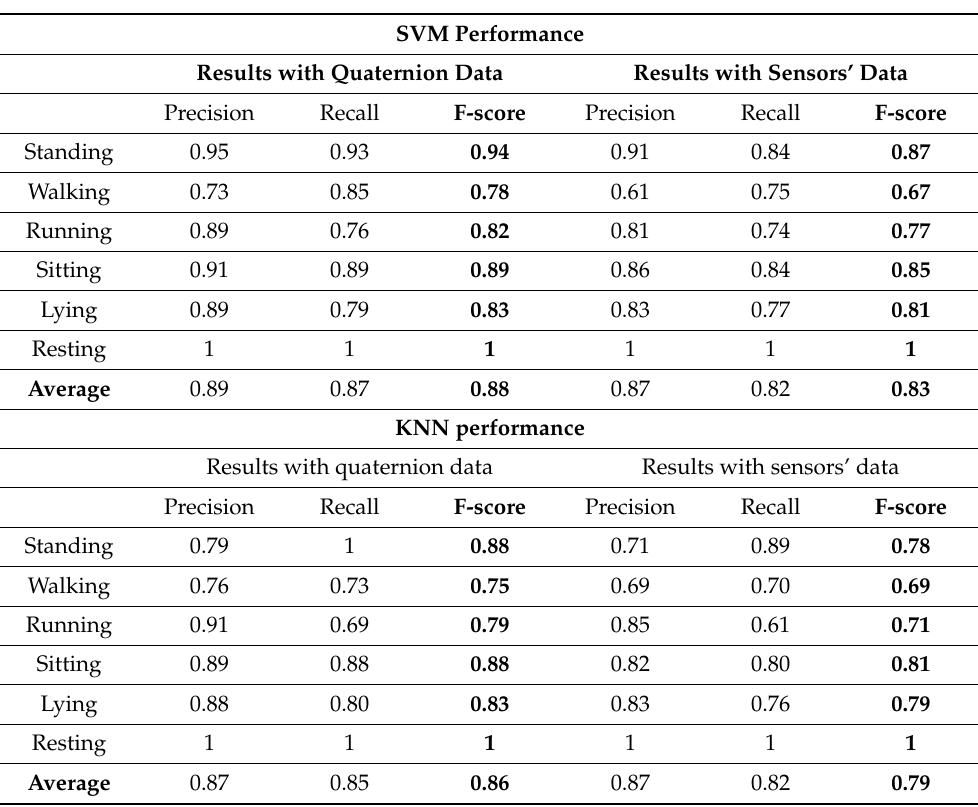
Table 3. Accuracy comparison of classifiers with two different datasets (dataset with quaternion values, dataset with sensors’